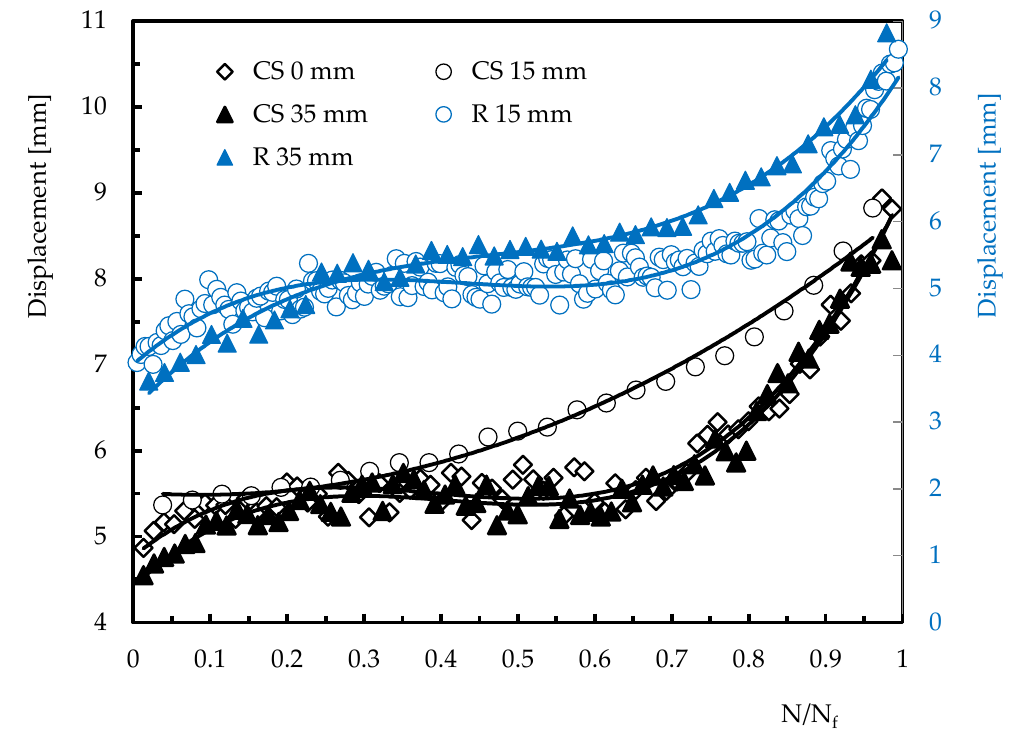
Figure 6. Displacement versus number of impacts for different geometries and distances.